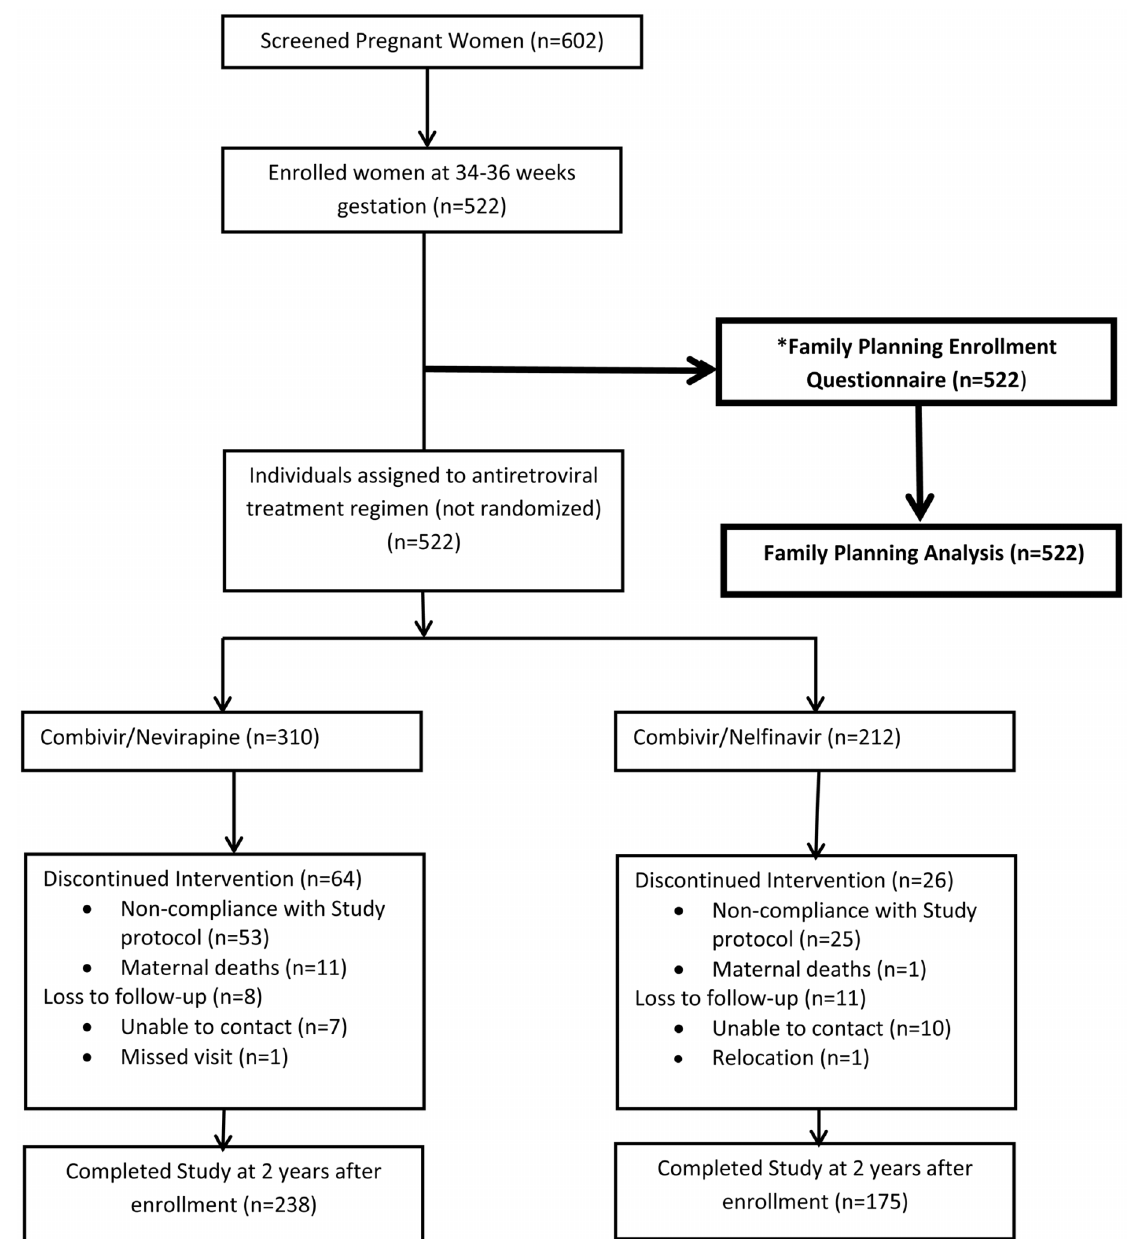
Figure 1. Flow diagram of women enrolled n the Kisumu breastfeeding study.